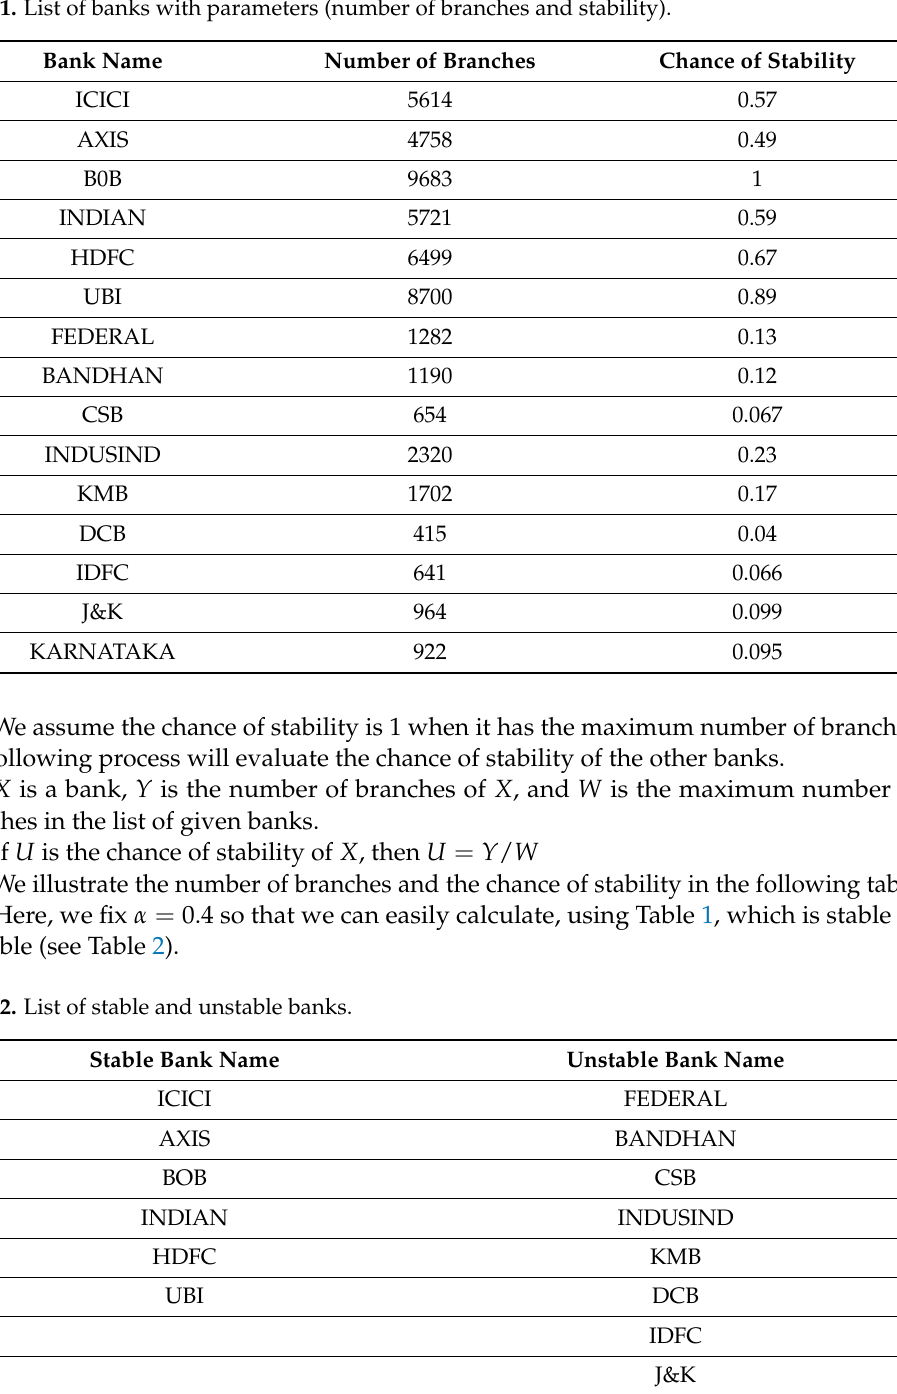
Table 1. List of banks with parameters (number of branches and stability).